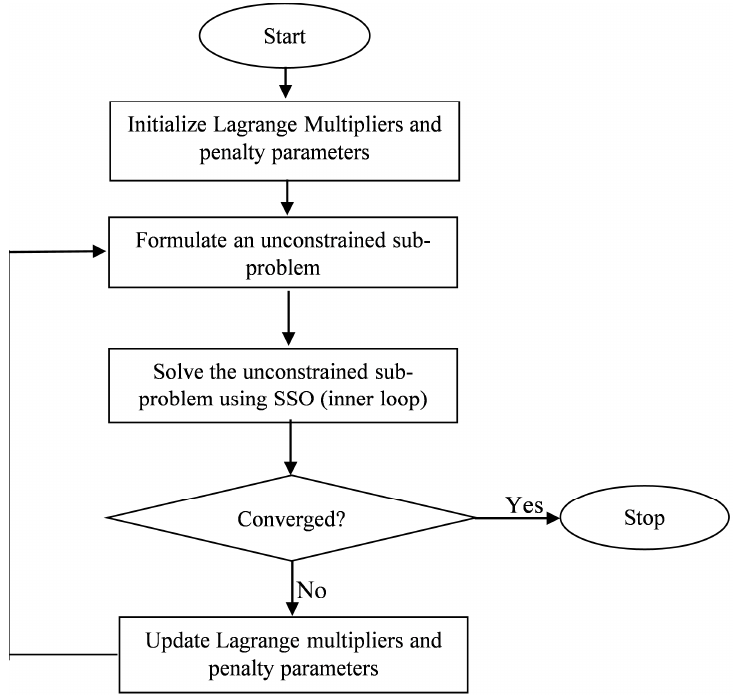
Figure 1. Flowchart of the proposed method.